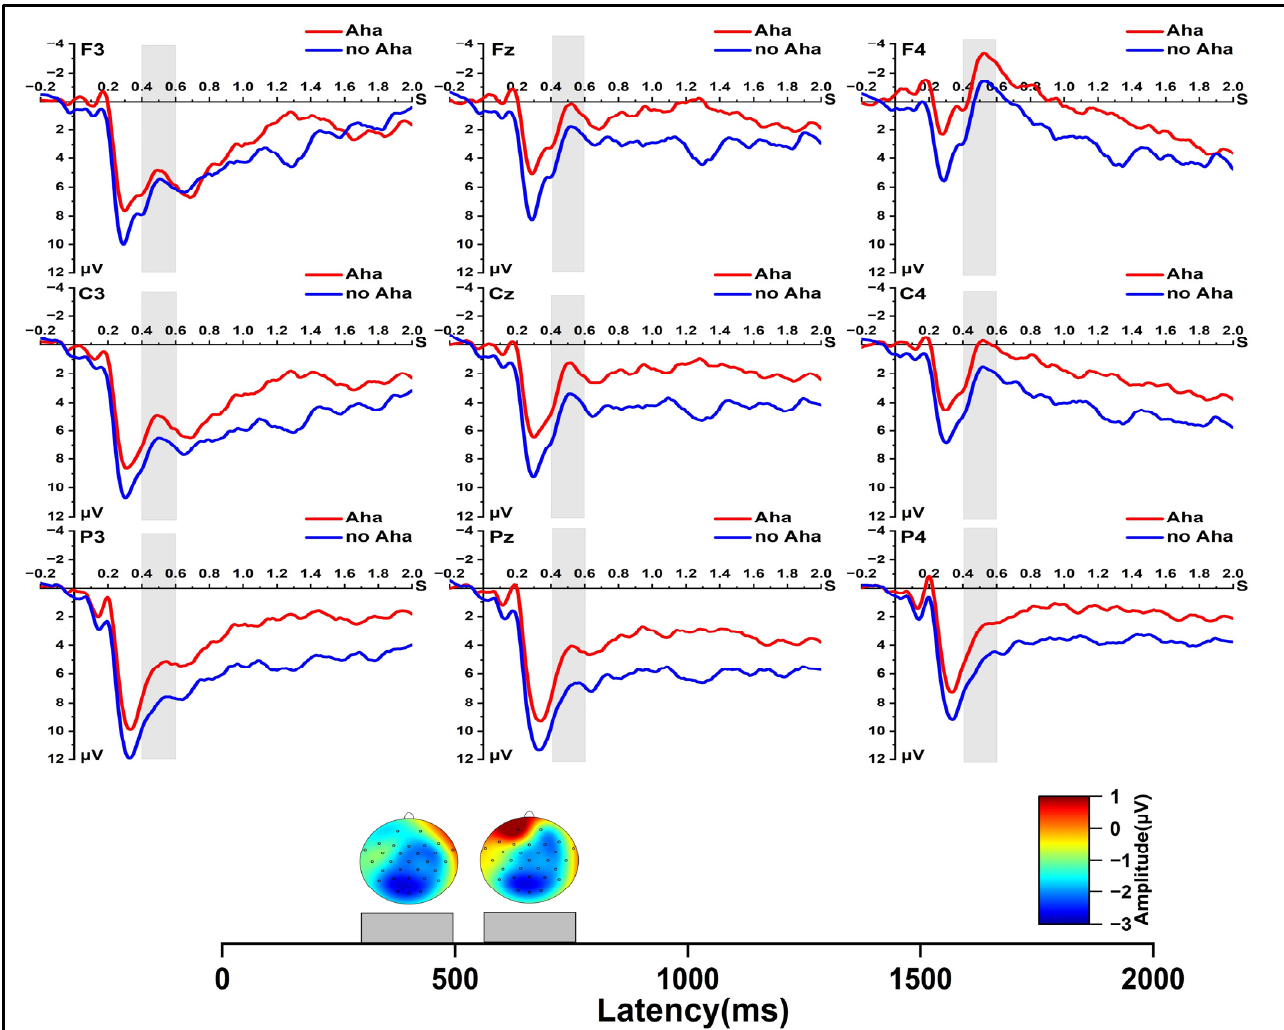
Figure 2. Grand-average ERPs from all selected channels for Aha and no Aha conditions and spher- ical-spline interpolated scalp distributions of the solution type (Aha minus no Aha) in 400~500 ms and 500~600 ms time windows.